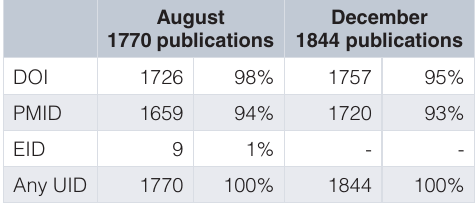
Table 4b. UID type for publications with UID exported from Pure to SciVal and not matched.